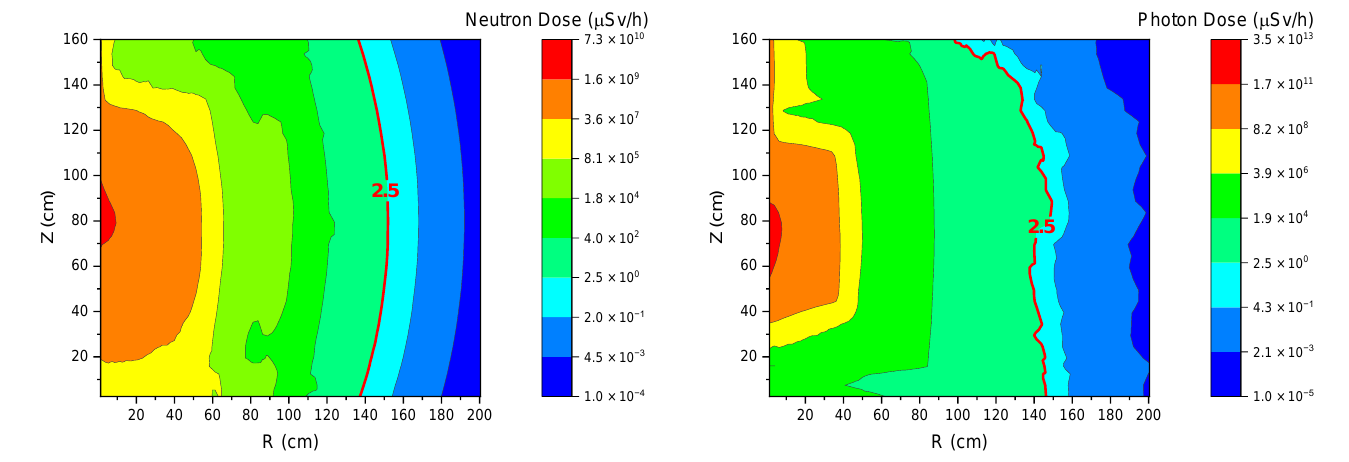
Figure 7. Neutron and photon dose map for TMR. 3.3. Tailoring the Ratio between the Bremsstrahlung Photons and the Emitted Neutrons